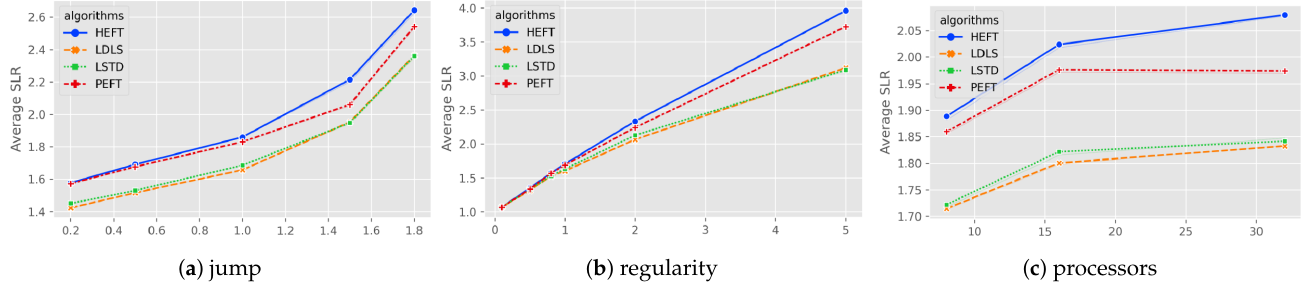
Figure 5. Average SLR for fast Fourier transform as a function of ( a ) heterogeneity of processors; ( b ) communication to computation ratio; ( c ) number of